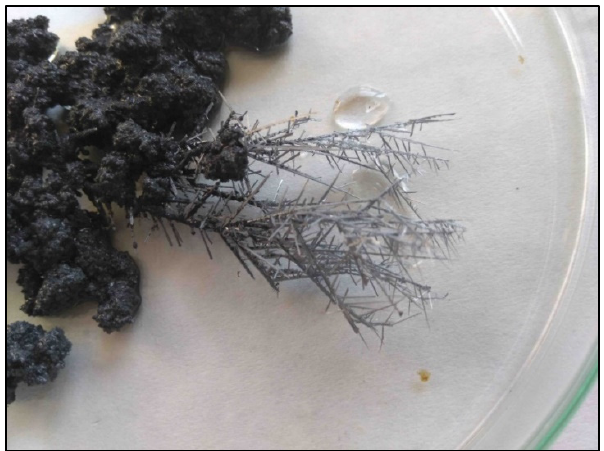
Figure 6. Photo documentation of the precipitated zinc on the cathode after the electrolysis [40]—sample B21. The appearance of cathode zinc with dendritic formations after the electrolysis has been documented. Conditions at the electrolysis are above in the text. Source: